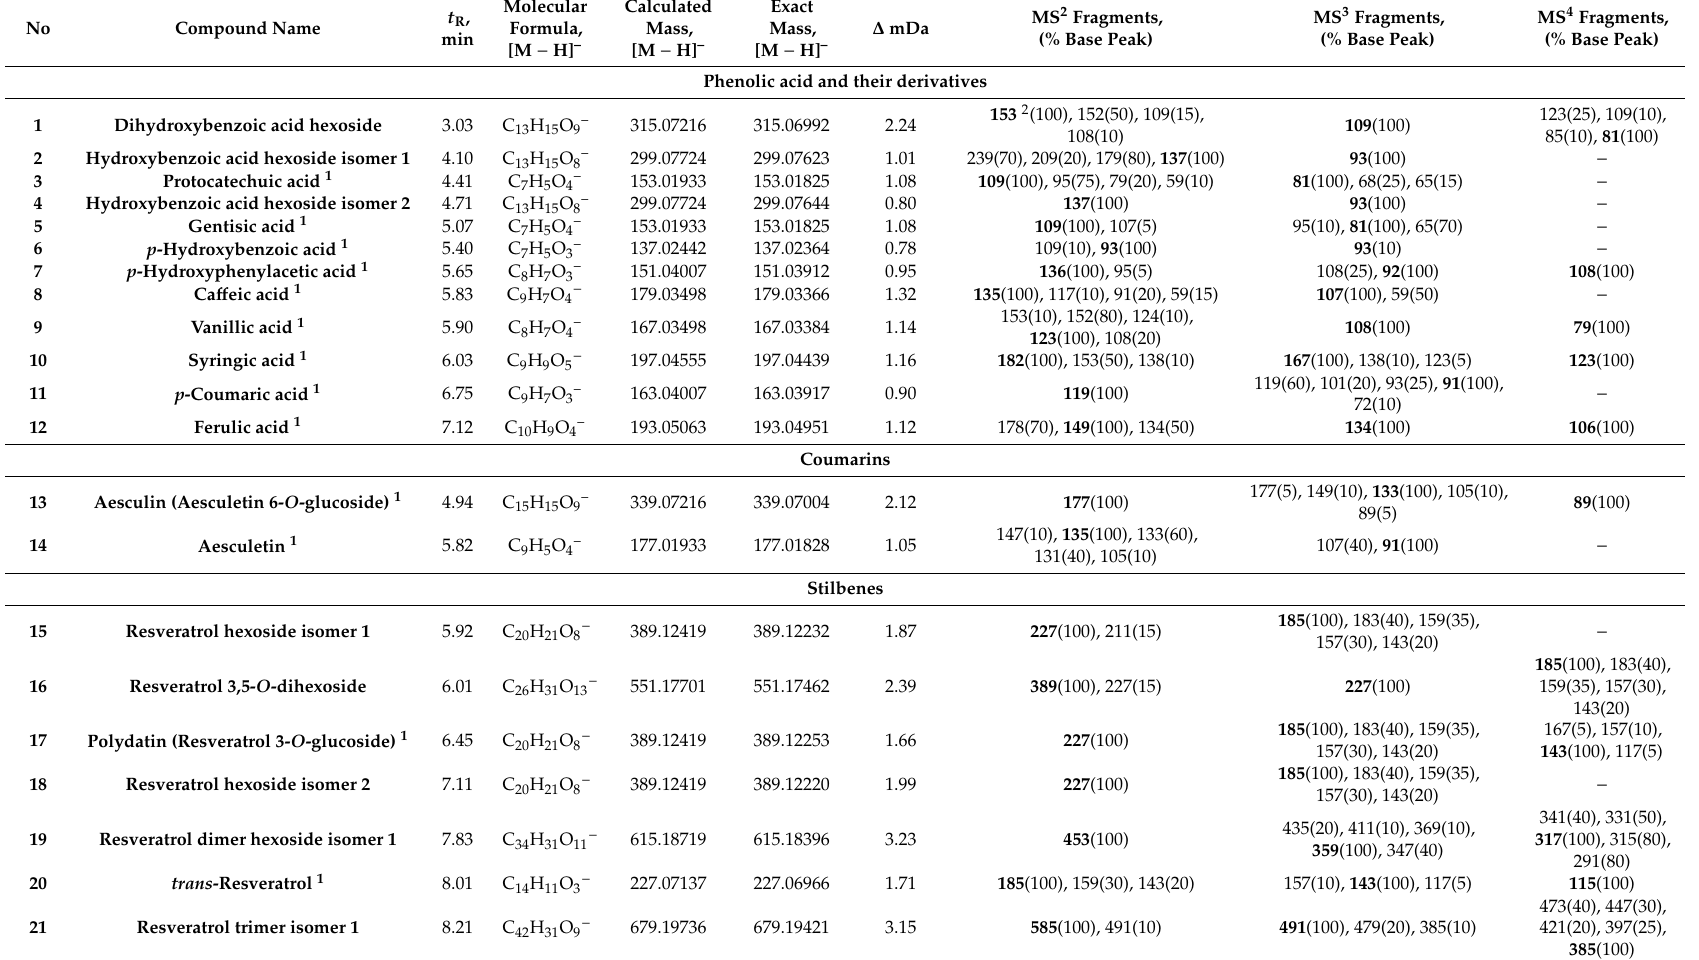
Table 2. High resolution and negative ion MS 4 data about identified